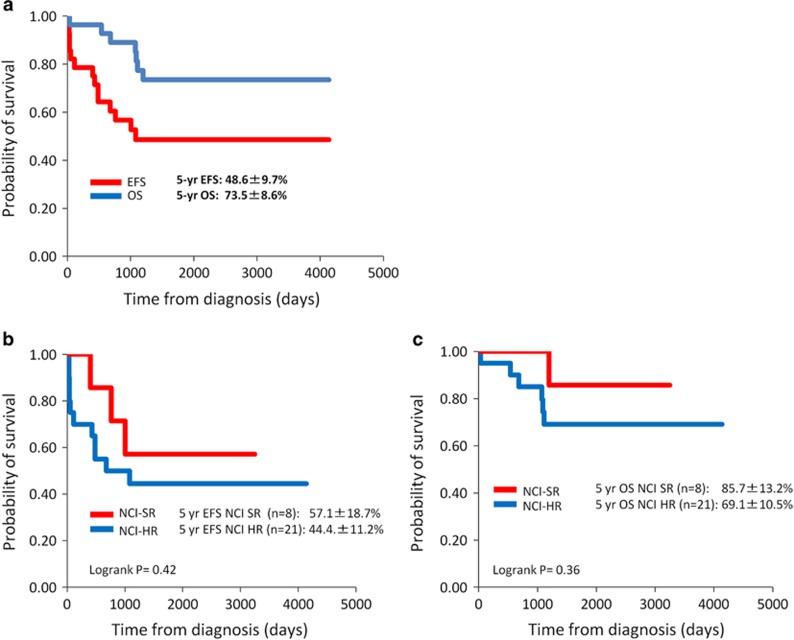
Probability of EFS and OS in 29 patients with kinase fusions (a) and according to NCI risk group. (b) EFS, (c) OS.